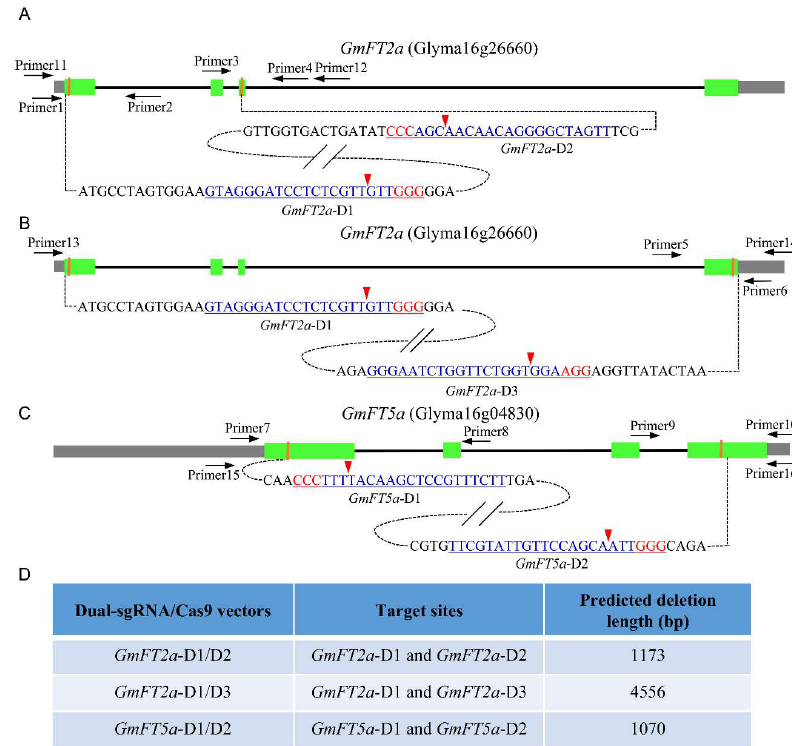
Figure 1. Gene structures of GmFT2a and GmFT5a with target sites of CRISPR/Cas9. Green stripe, exon; black solid line, intron; gray stripe, UTR (untranslated region). ( A , B ) GmFT2a -D1, GmFT2a -D2, and GmFT2a -D3 were target sites of CRISPR/Cas9 designed in the first, third, and fourth exon of GmFT2a , respectively. ( C ) GmFT5a -D1 and GmFT5a -D2 were target sites of CRISPR/Cas9 designed in the first and fourth exon of GmFT5a , respectively. Red letter, PAM (protospacer adjacent motif). The red arrowheads indicate the cleavage sites of the CRISPR/Cas9 system. Primer1–16 are specific primers used for PCR. ( D ) Combinatory dual-sgRNA/Cas9 vectors for targeted fragment deletions of GmFT2a and GmFT5a